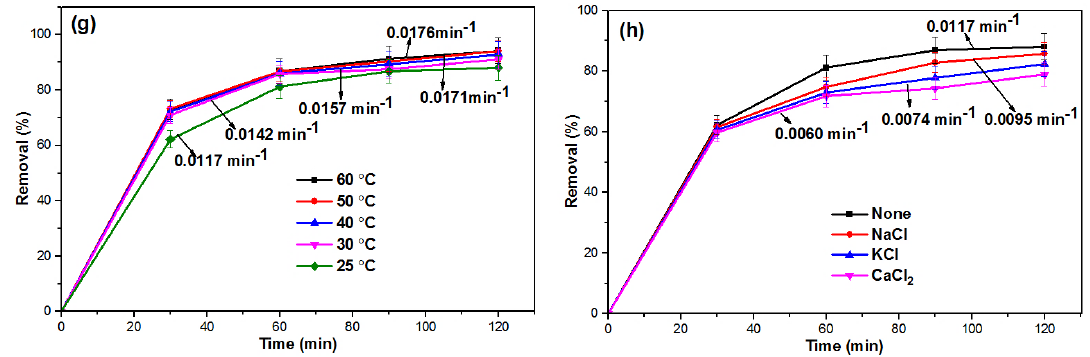
Figure 7. Effects of ( a ) Fe 3 O 4 loading on zeolite, ( b ) FeZ-8 catalyst dosage, ( c ) initial solution pH, ( d ) initial OFL concentration, ( e ) different oxidants, ( f ) H 2 O 2 dosage, ( g ) reaction temperature, and ( h ) inorganic ions on the Fenton degradation of OFL. Unless stated otherwise, reaction conditions are based on: [OFL] = 20 mg/L, pH = 9, (FeZ-8) = 1 g/L, (H 2 O 2 ) = 5 mL/L.